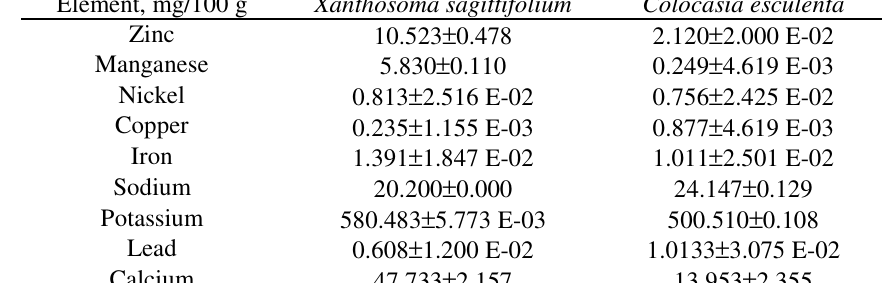
Table 3. Vitamin composition of cocoyam